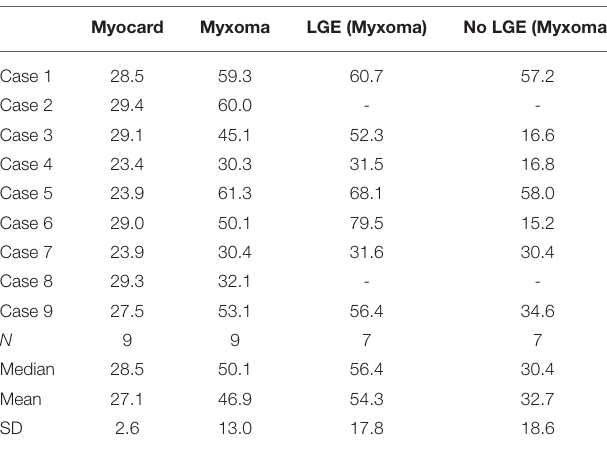
Case 2: Myxoma area on LGE and Mapping images not overlapping. Case 8: No LGE. LGE,LateGadoliniumEnhancement.N,Numberofobservations.SD,StandardDeviation.